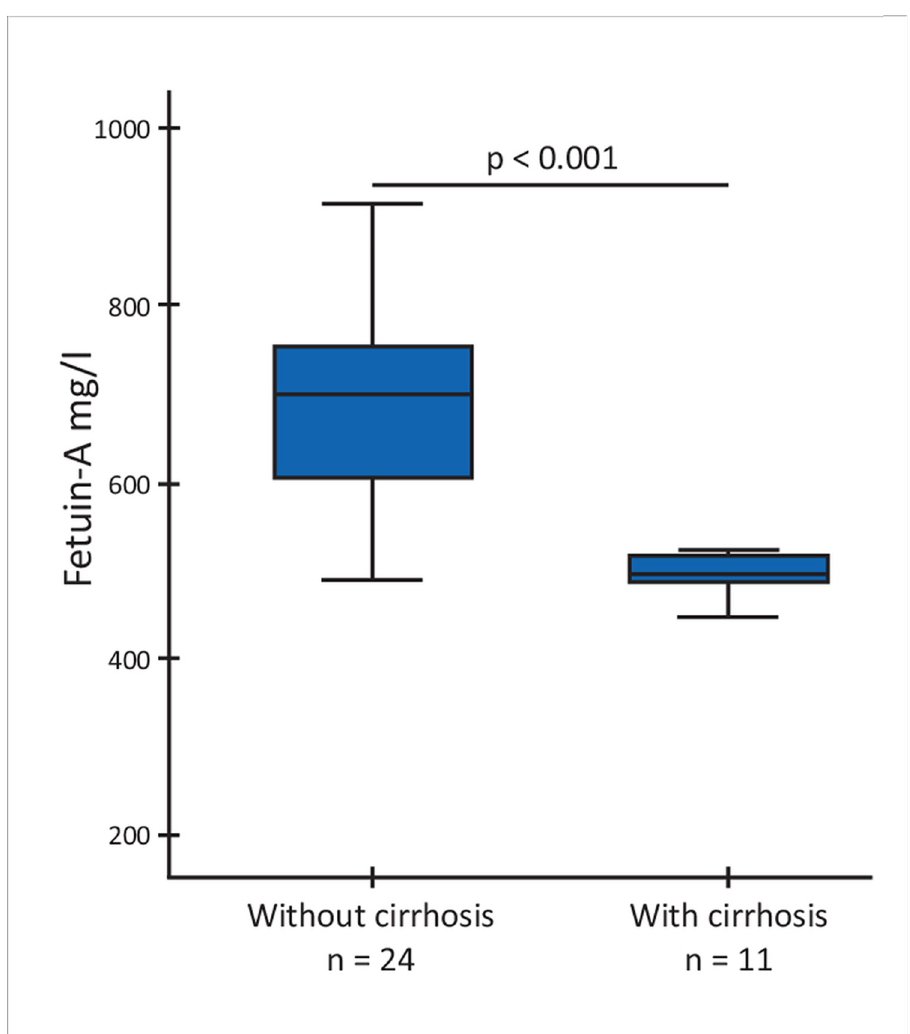
Fig 1. Serum fetuin-A concentration in Wilson’s patients with liver involvement without and with cirrhosis (Mann-Whitney U test).